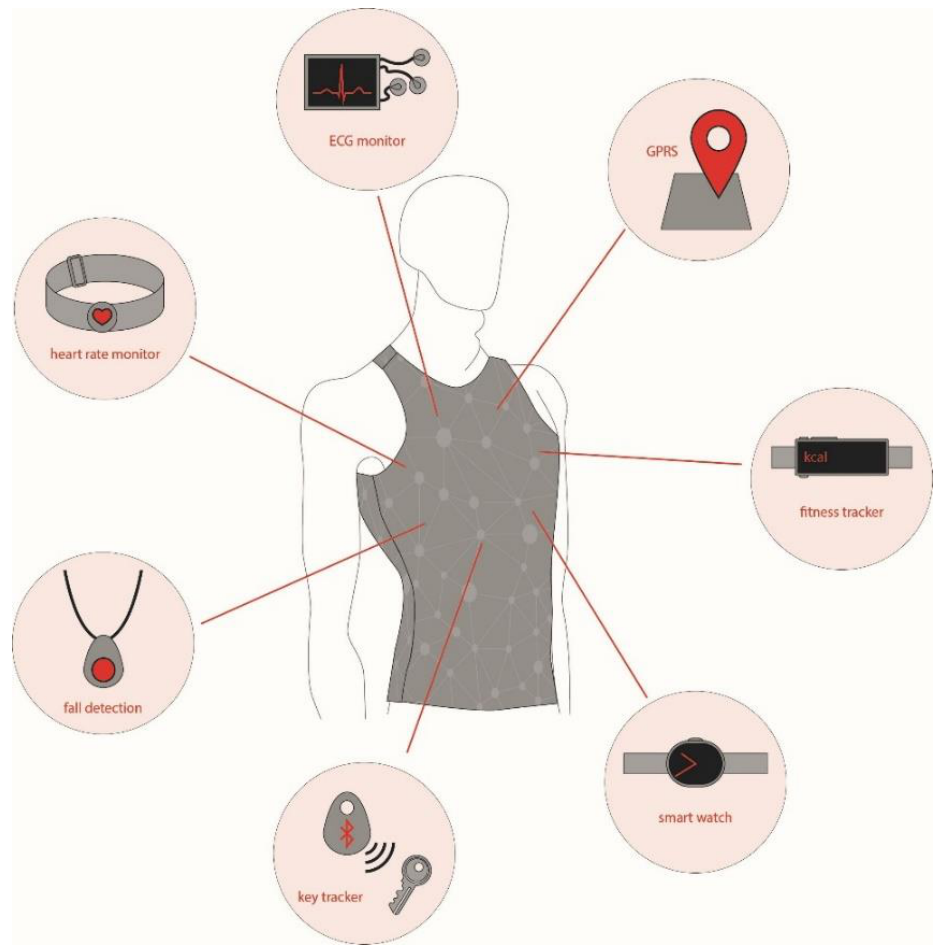
Figure 1. Concept of Wearable 2.0. ECG, electrocardiogram.